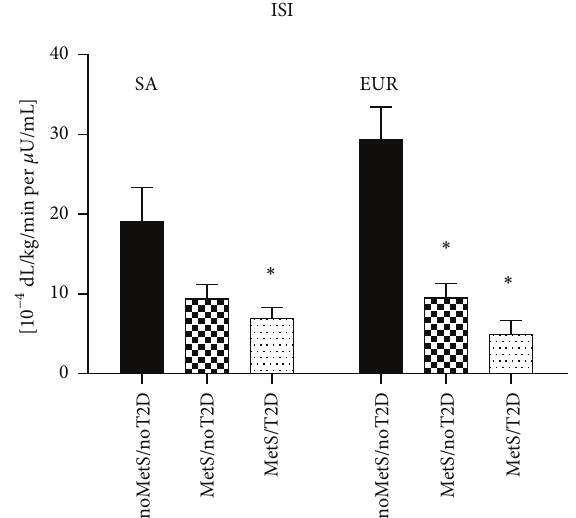
Figure 1: Insulin sensitivity index (ISI) assessed by the OMM in South Asian (SA) and European (EUR) subgroups. ∗ indicates a statisticallysignificantdifferencebetweennoMetS/noT2Dandother